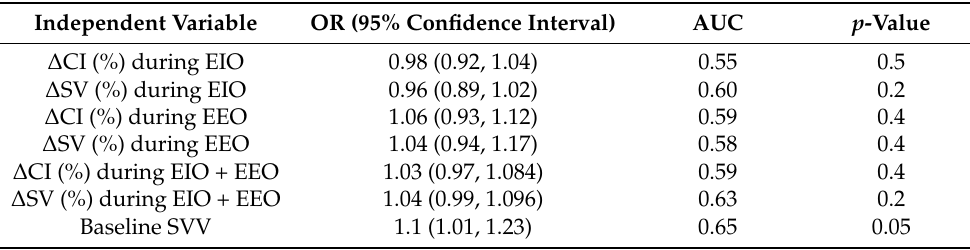
Table 4. Univariate logistic regression analysis for the dependent parameter ∆ CI during fluid challenge, binarized as ≥ 15% vs. <15%.